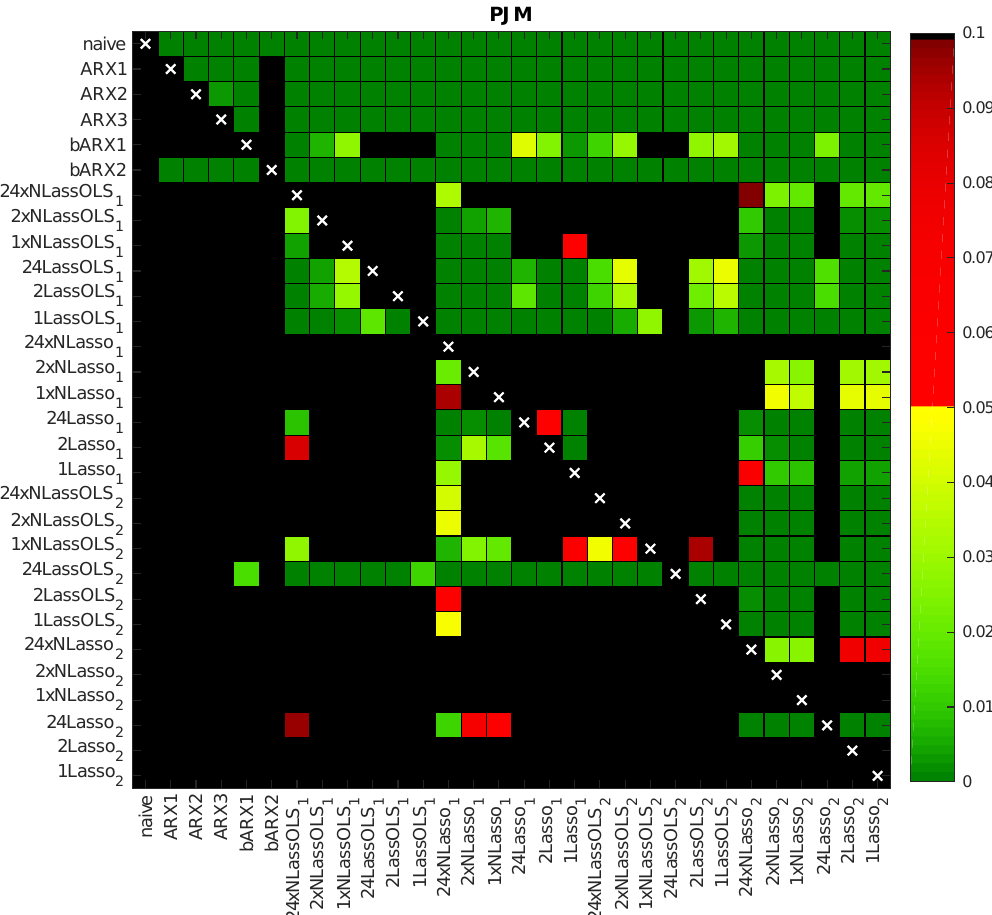
Figure 5. Results of the ‘multivariate’ DM test for PJM for the same 30 models as in Table 1 and the N-PIT transformation. A heat map is used to indicate the range of the p -values—the closer they are to zero ( → dark green), the more significant the difference is between the forecasts of a model on the X-axis (better) and the forecasts of a model on the Y-axis (worse).